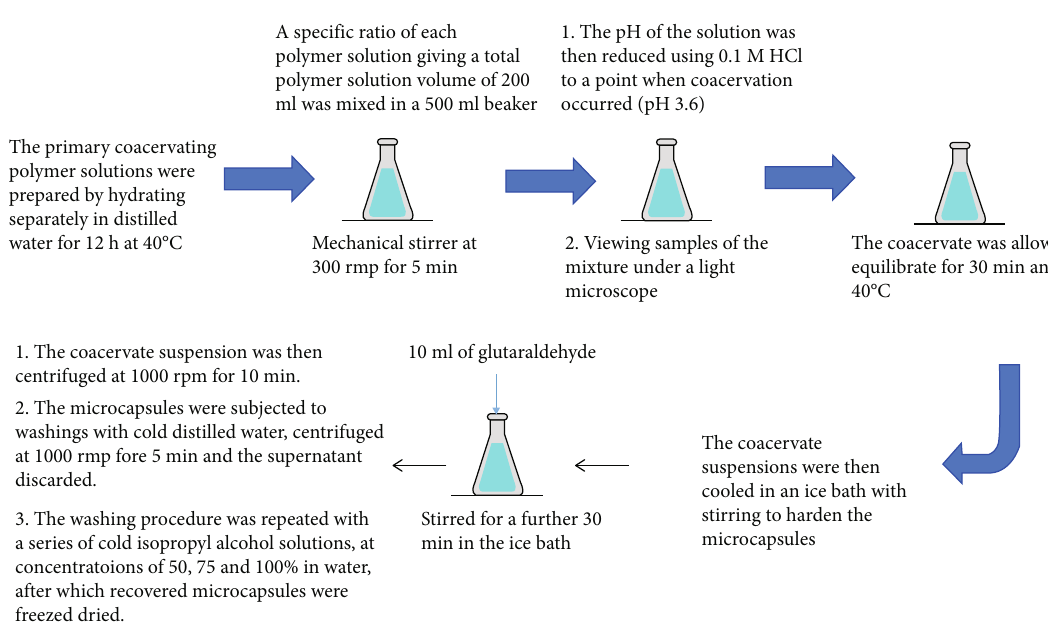
Figure 27: Schematic representation of the HA/gelatin and acacia/gelatin microcapsules using a complex coacervation method